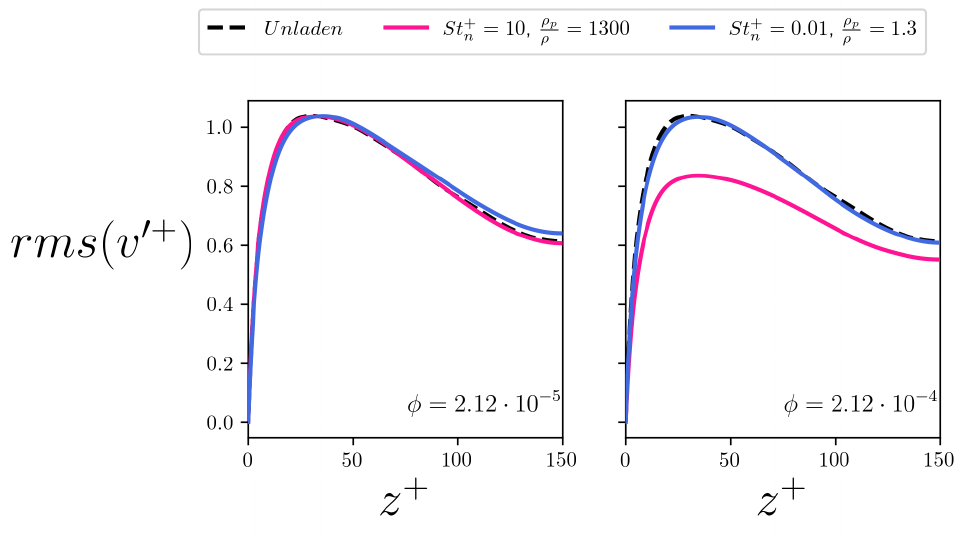
Figure 15. Root mean square (rms) of the spanwise fluid velocity along the wall-normal coordinate. The left panel refers to the φ = 2.12 · 10 − 5 case, the right panel refers to the φ = 2.12 · 10 − 4 case. The curves relative to the St + n = 0.01 fibers are plotted in blue while the curves relative to the St + n = 10 fibers are plotted in pink. The curve of the unladen flow case is plotted in dashed black for